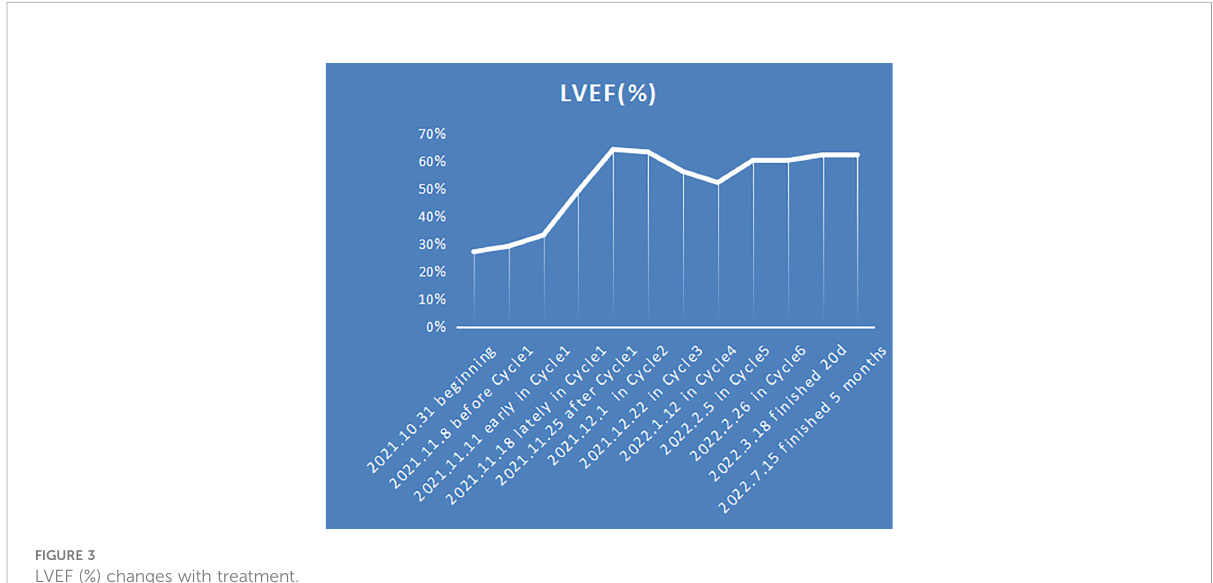
FIGURE 3 LVEF (%) changes with